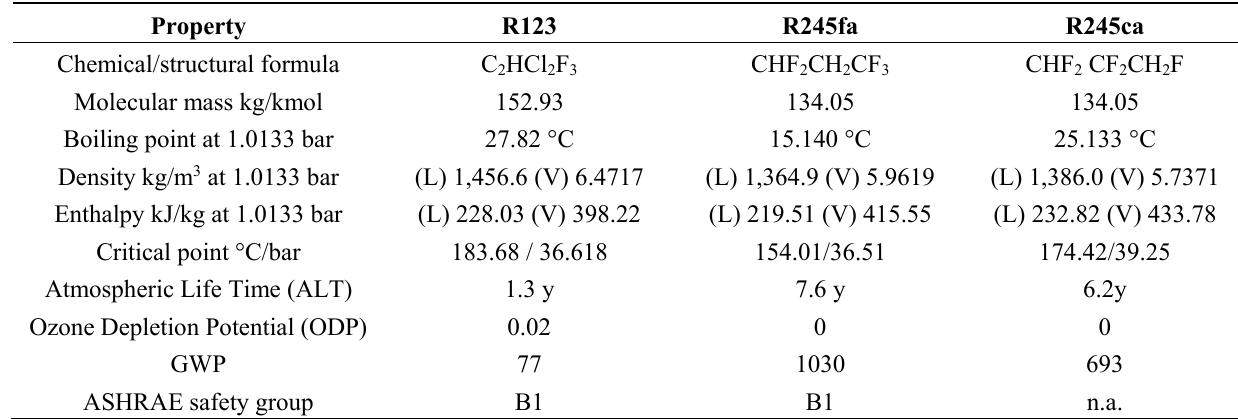
Table 2. Properties of R123, R245fa and R245ca